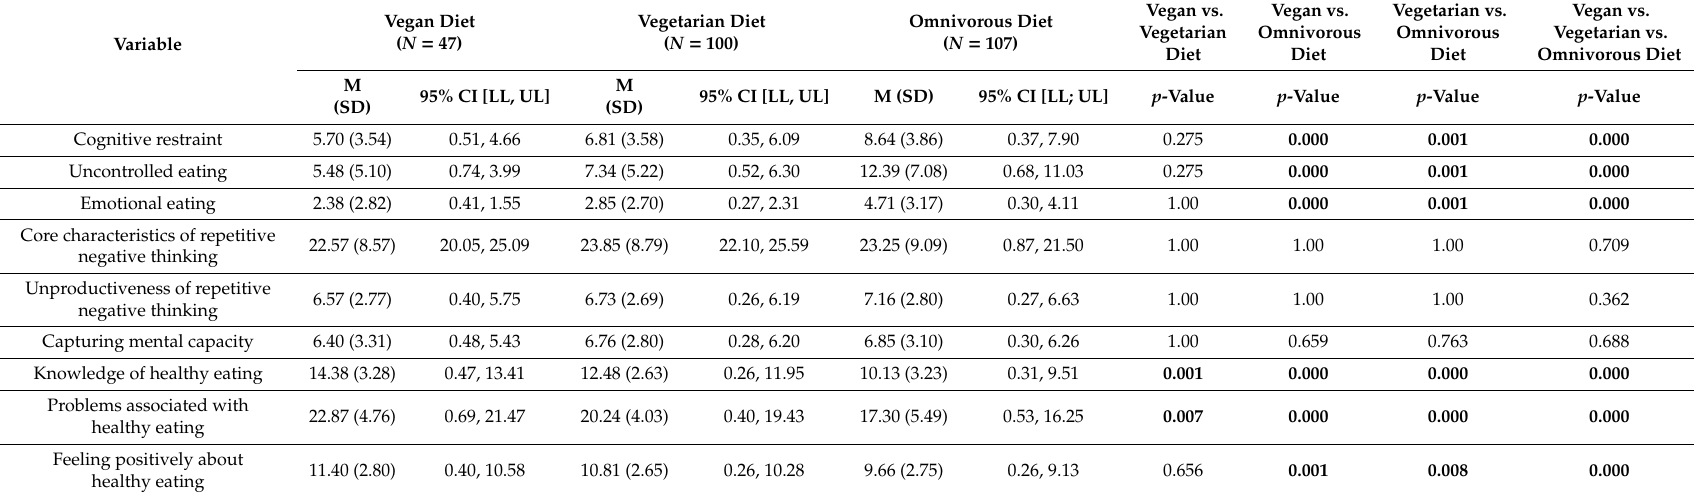
Table 4. The mean (M) (and standard deviation; SD) eating behaviours, orthorexia nervosa and repetitive negative thinking across the dietary patterns.